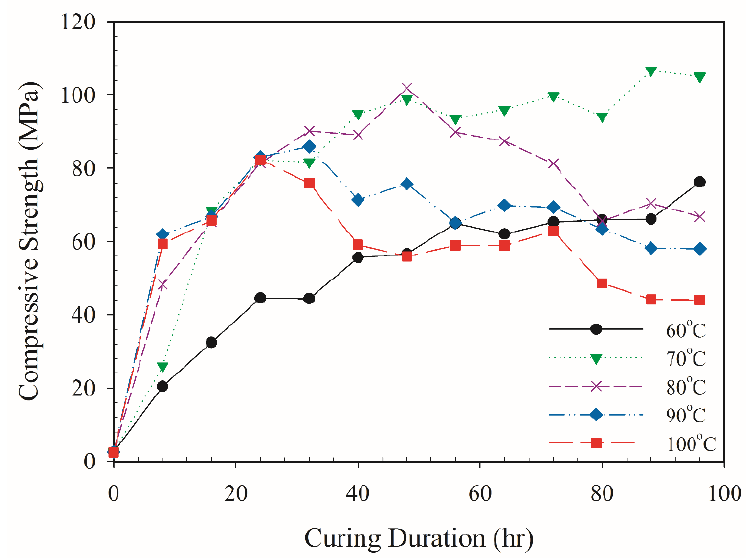
Figure 3. Variations with curing duration in the 4-day compressive strength of geopolymer specimens at various curing temperatures when AE% = 2%.